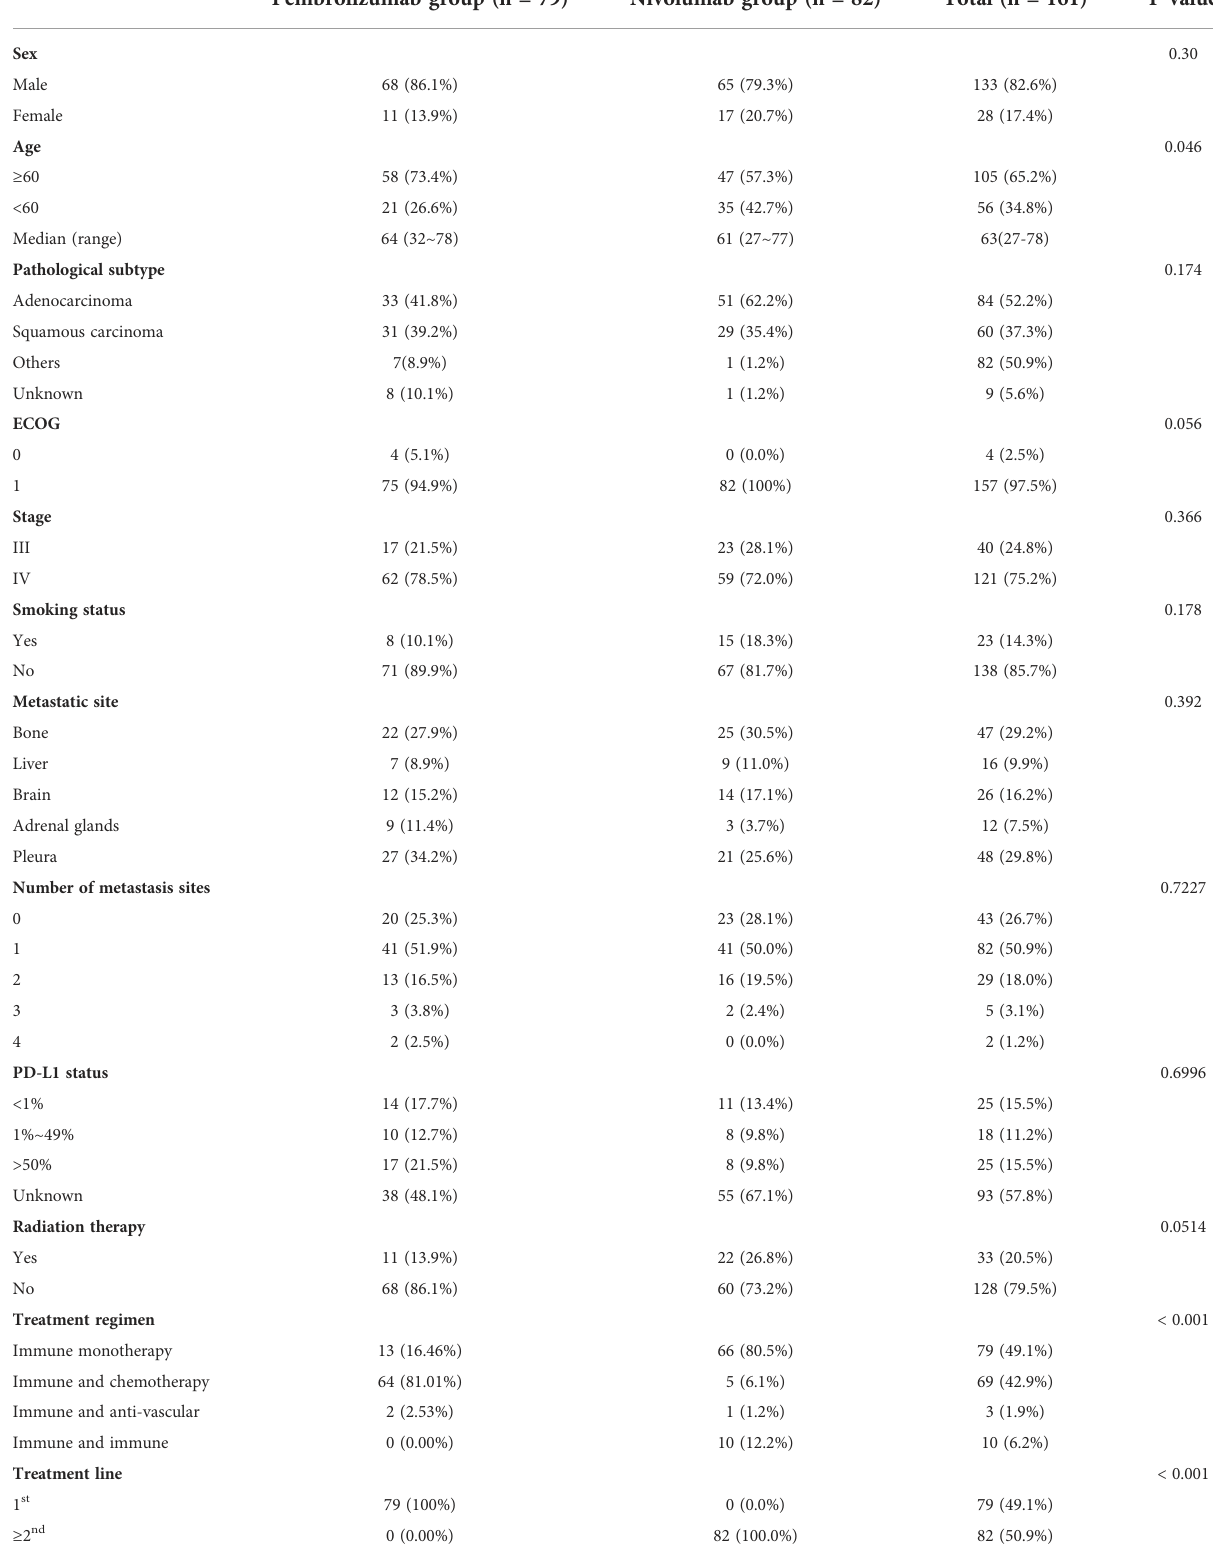
TABLE 1 Demographic and clinical characteristics of the study